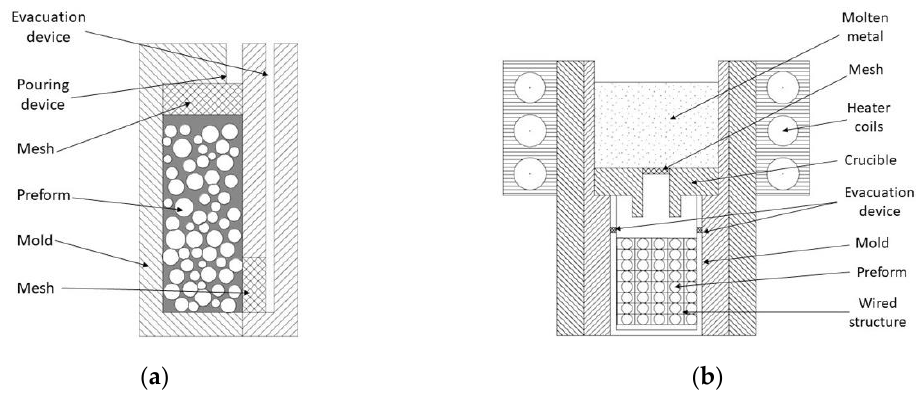
Figure 6. ( a ) Schematic representation of the DPLI set-up adapted from Licitra et al. [101]; ( b ) DPLI set-up adapted from Castro et al. [74].